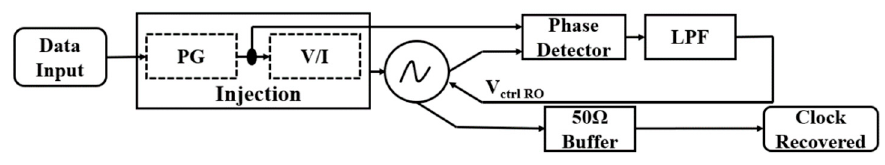
Figure 1. Full 3.2 GHz injection-locked PLL architecture.